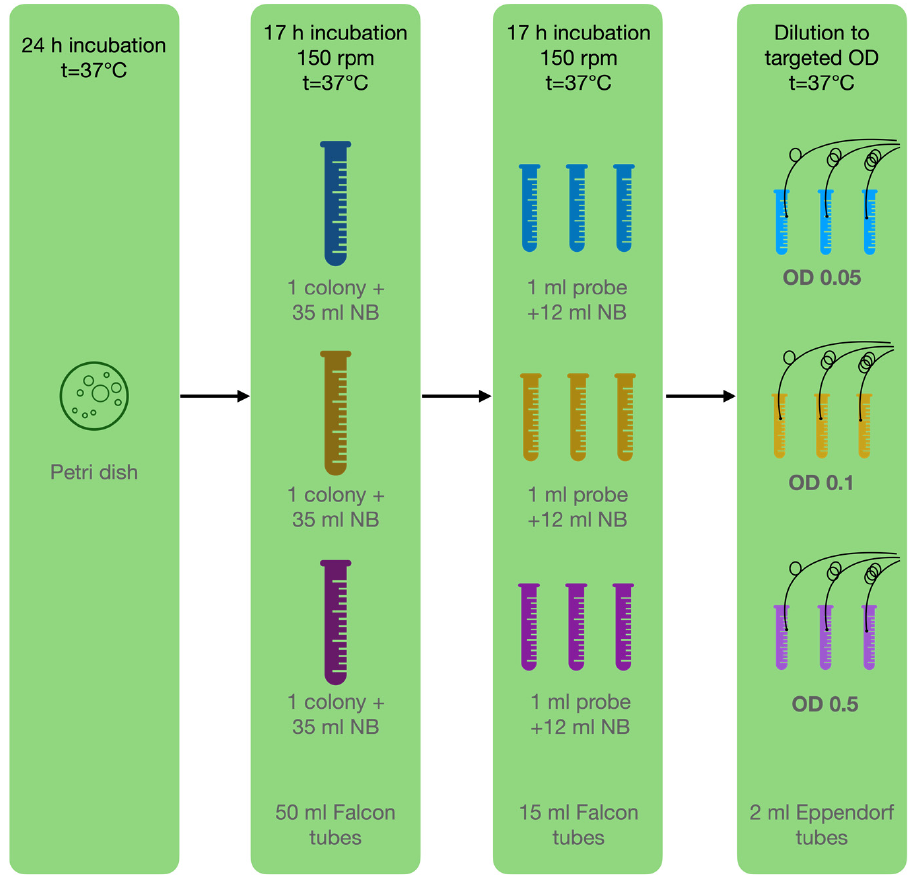
Figure 4. Microbiological methodology: Step 1—cultivate bacteria on Petri dish; step 2—inoculation of one pure colony in 3 tubes with NB; step 3—inoculation of 3 separate replicants for each experiment in NB; step 4—dilution to targeted OD for experiment.